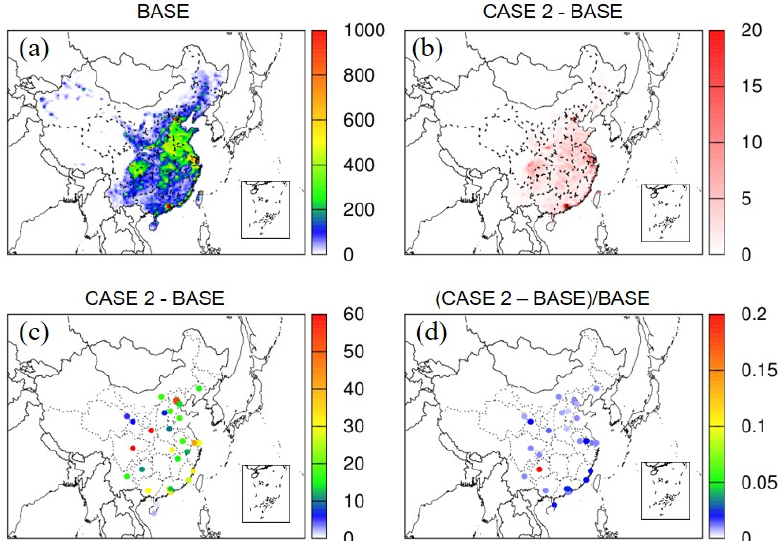
Figure 5. The total O 3 -related premature mortality rate of (a) BASE case and its difference from CASE 2 across China (b) and in major cities (c, d)